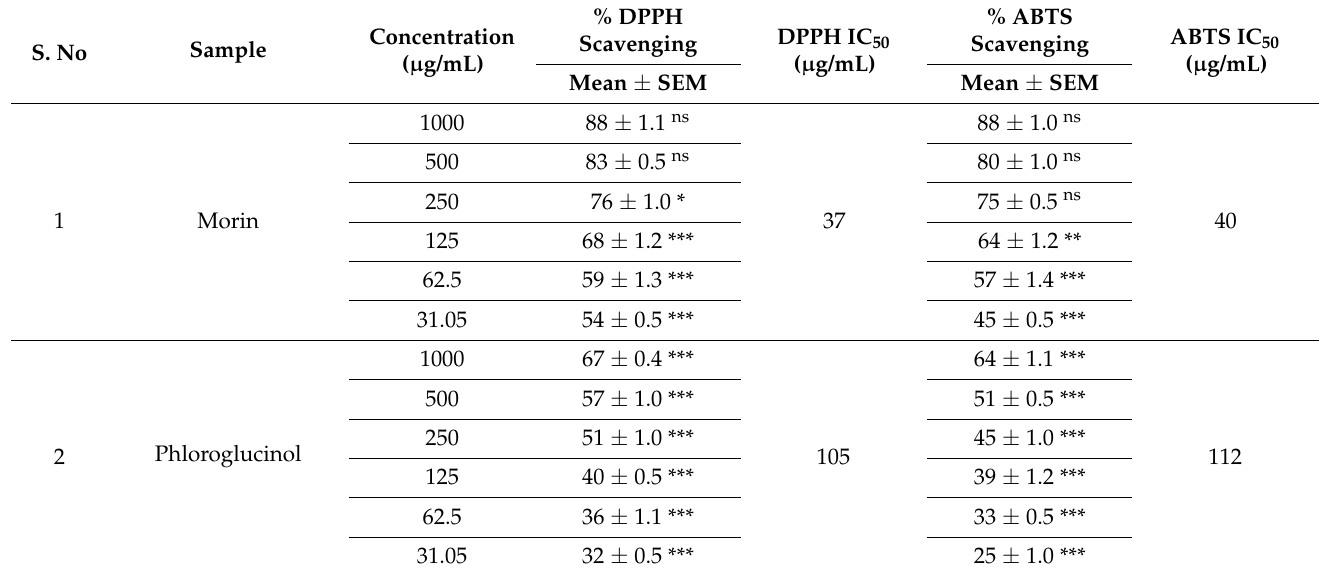
Table 2. Percent DPPH and ABTS free radical scavenging activity of compounds (morin, phloroglucinol, 1-hexyl benzene) isolated from Elaeagnus umbellata berries at various concentrations.